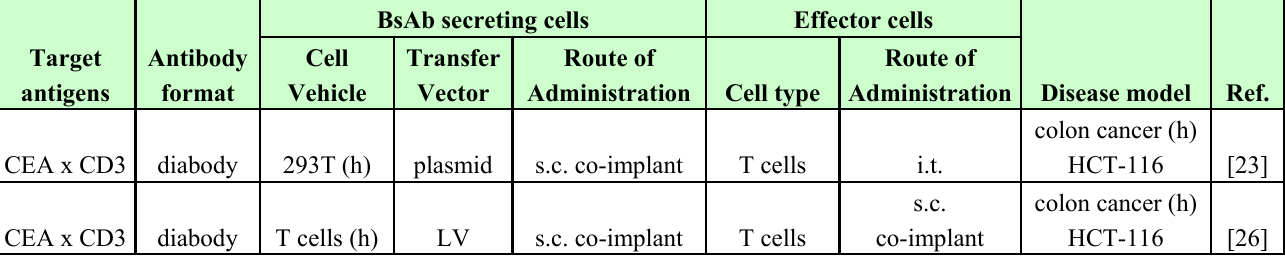
Table 1. Different strategies for in vivo production of bispecific